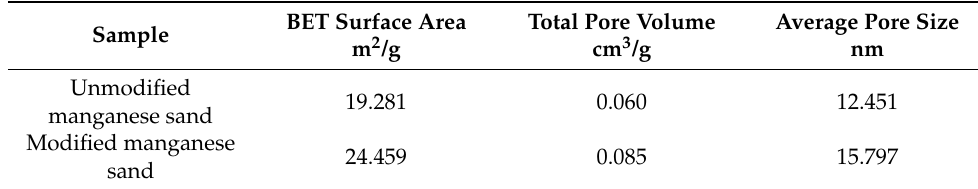
Table 2. BET test results of manganese sand. Sample